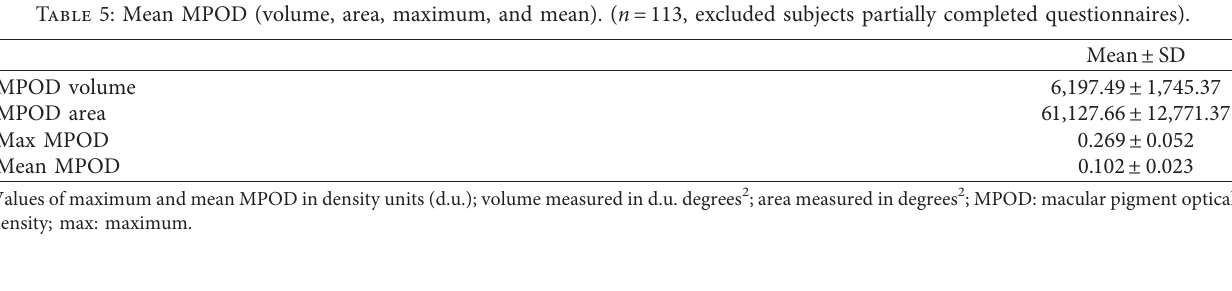
Table 6: Correlation between mean MPOD and the intake of 7 foods rich in L / Z among participants ( n � 120). Ivy gourd Chinese Flowering cabbage Balsam pear Lettuce Sweet corn Pumpkin Chilli peppers Mean MPOD 0.217 ∗ 0.194 ∗